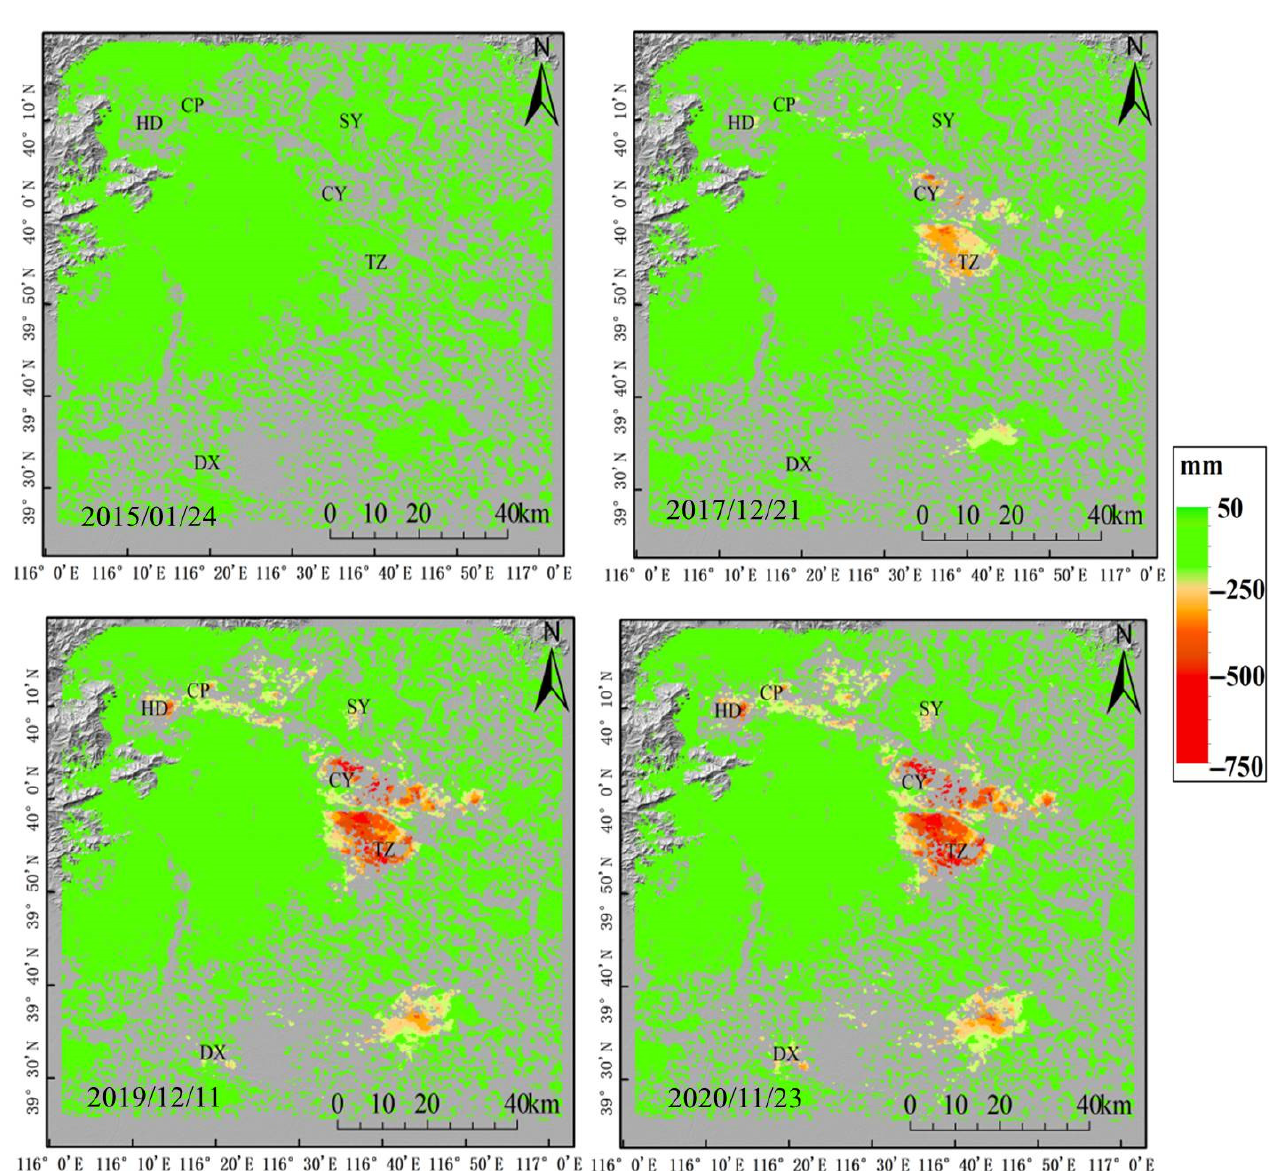
Figure A2. Cumulative time-series deformation along the LOS from 2015 to 2020. CY: Chaoyang District, CP: Changping District, HD: Haidian District, SY: Shunyi District, and TZ: Tongzhou District.